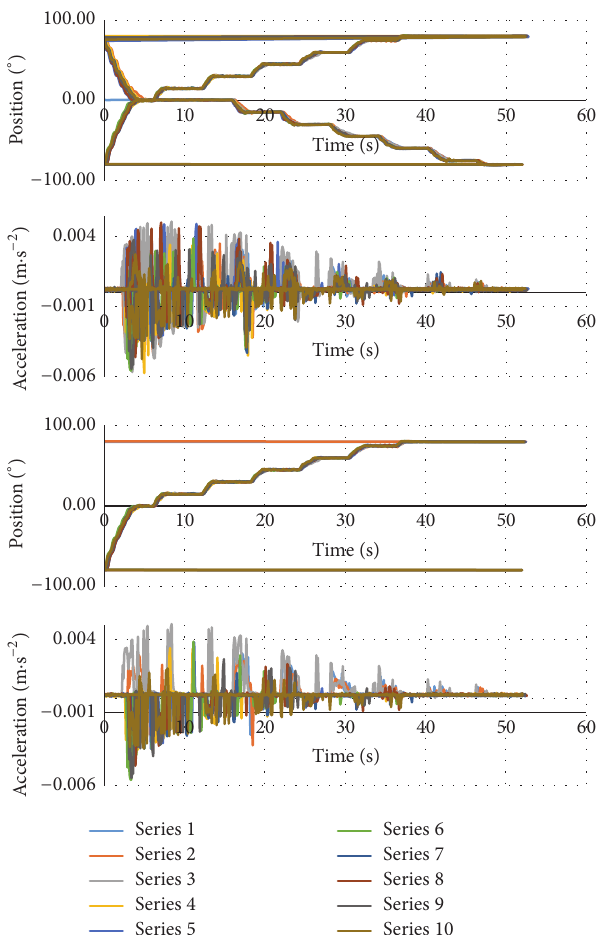
Figure 9: The graphical representation of a current position and the supporting arm acceleration.